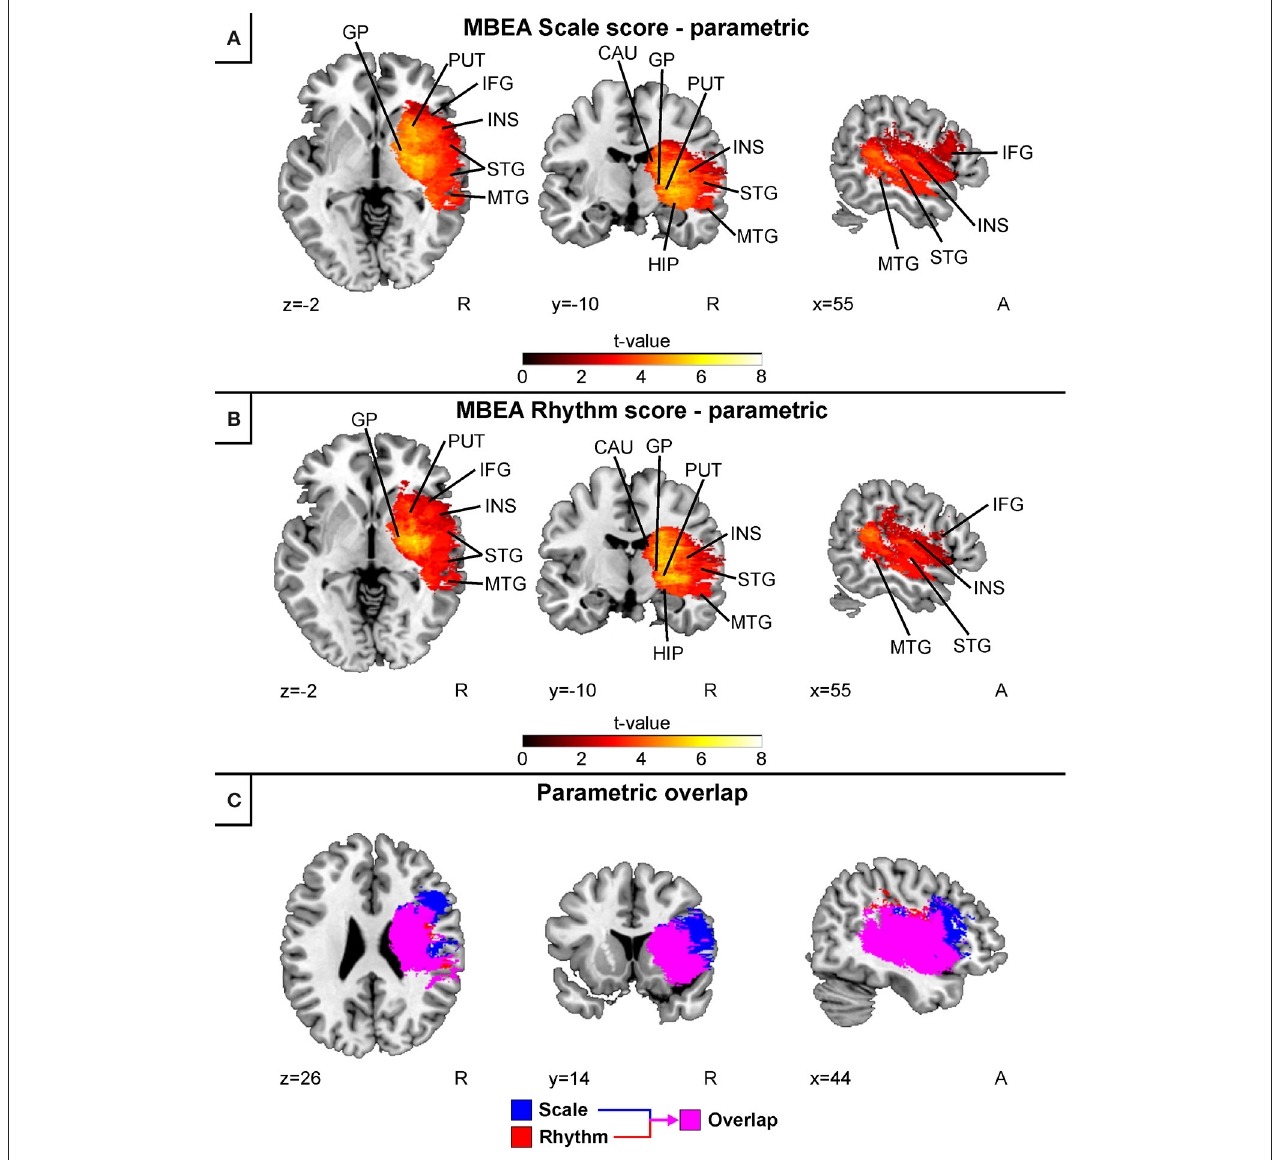
FIGURE 3 | Acute stage VLSM results for scale and rhythm amusia: pooled analysis. Continuous analyses of (A) MBEA Scale score and (B) MBEA Rhythm score. (C) is an overlap image comparing Rhythm (red) and Scale (blue) subtests’ continuous results. Neurological convention is used with MNI coordinates at the bottom left of each slice. All statistical maps are thresholded at an FDR-corrected p < 0.05 threshold. Critical brain structures are labeled. CAU, Caudate; GP, globus pallidus; HIP, hippocampus; IFG, inferior frontal gyrus; INS, insula; MTG, middle temporal gyrus; PUT, putamen; STG, superior temporal gyrus.